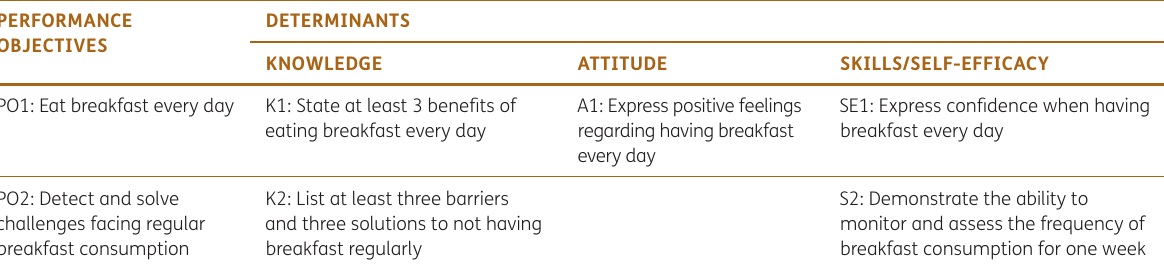
Table 1 Example of behavioral outcome, performance objectives, change objectives and their corresponding determinants (the complete matrix is listed in Supplementary file